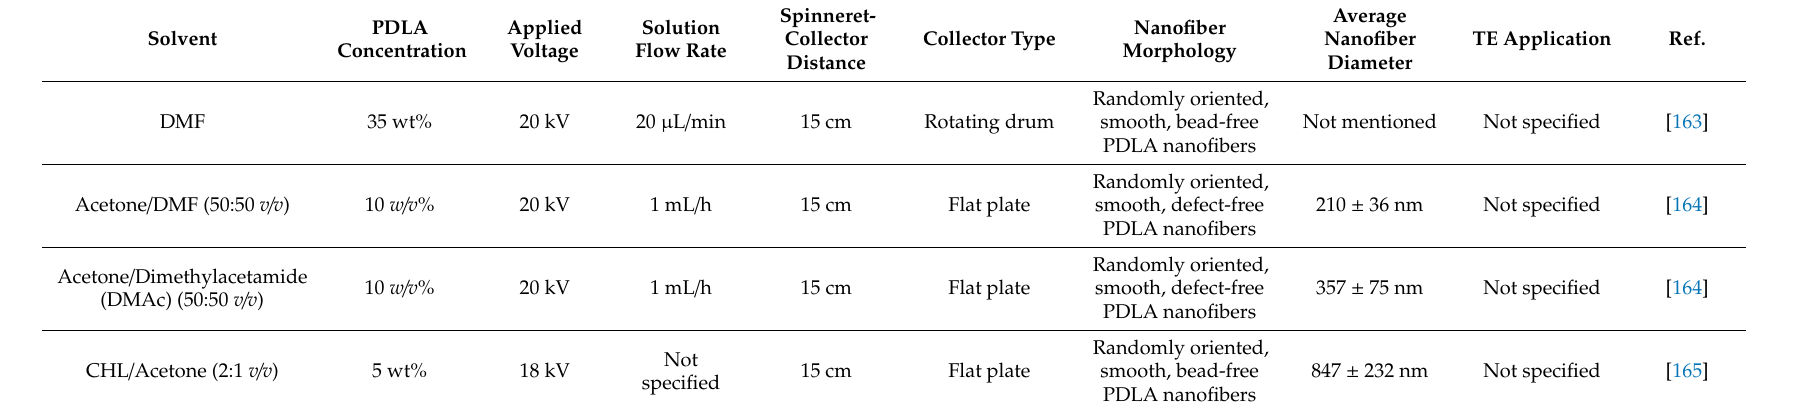
Table 3. Some examples of the fabrication of electrospun PDLA sca ff olds for TE